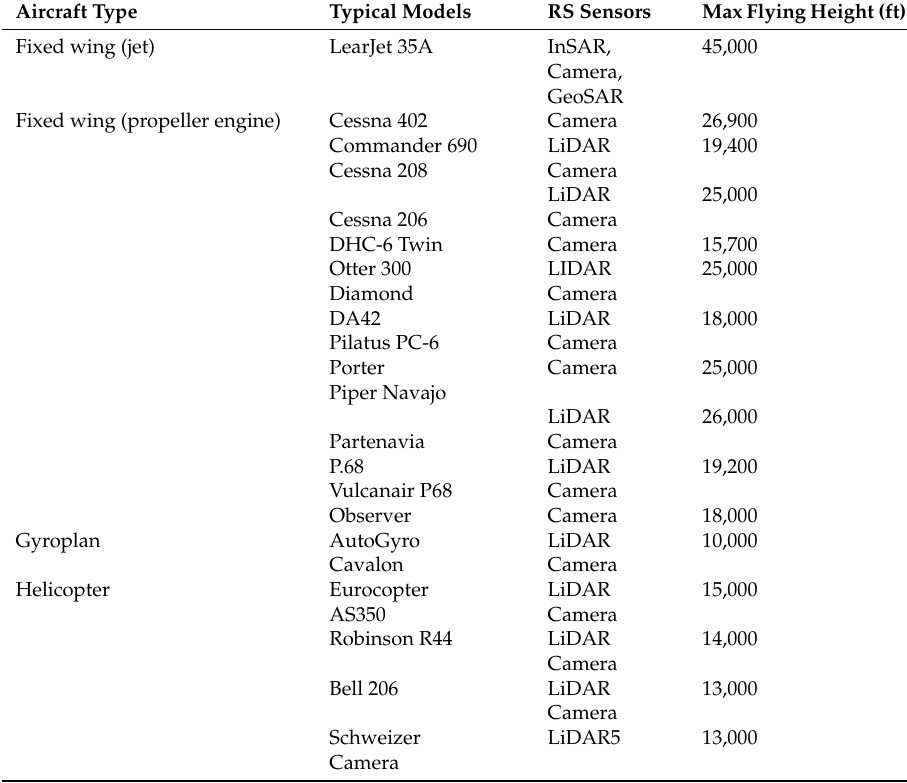
Table 6. Airborne/aircraft platforms for